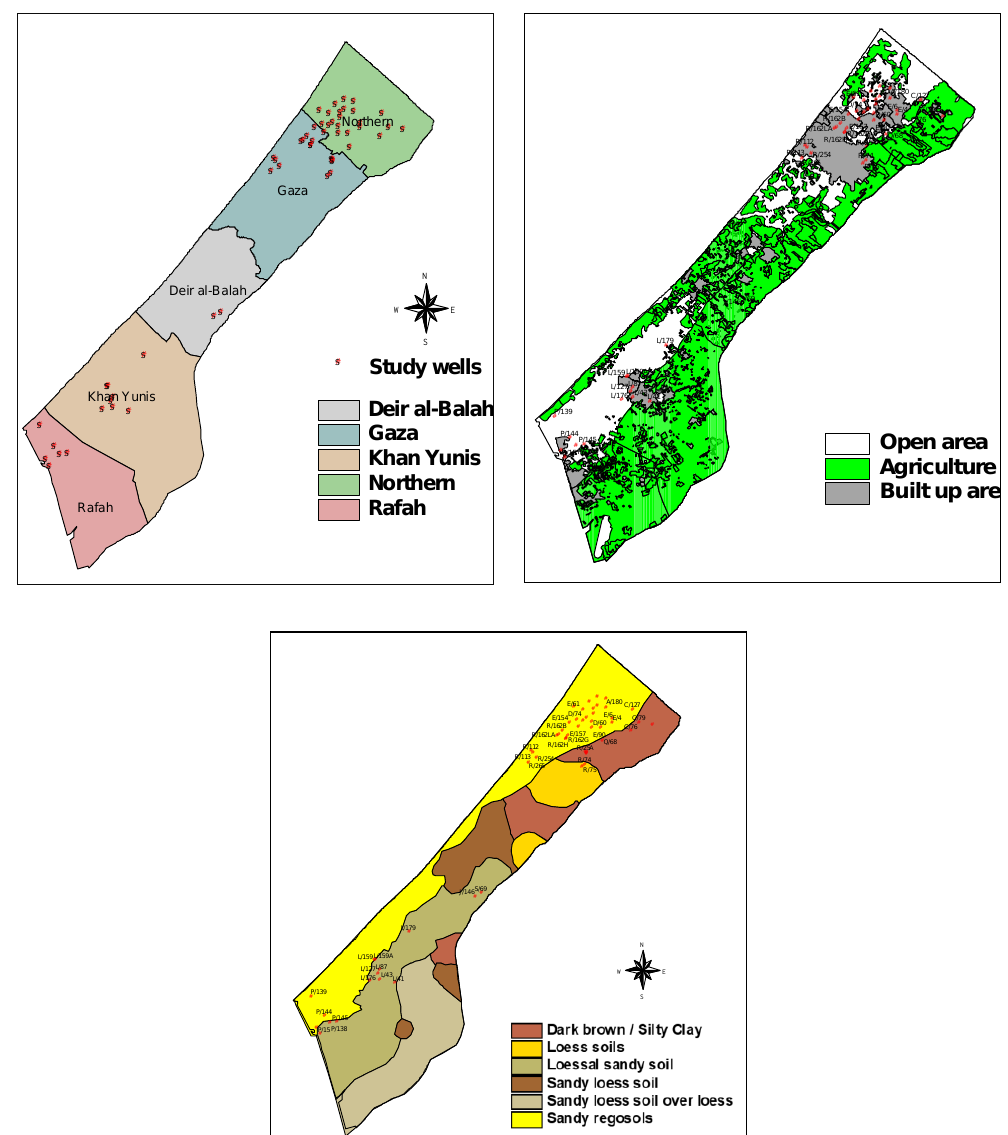
Figure 4. Study wells ’ spatial distribution in Gaza Strip in terms of land use and soil type.